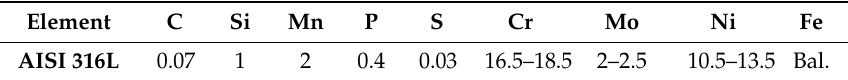
Table 1. Chemical composition of base material (wt. %). Element